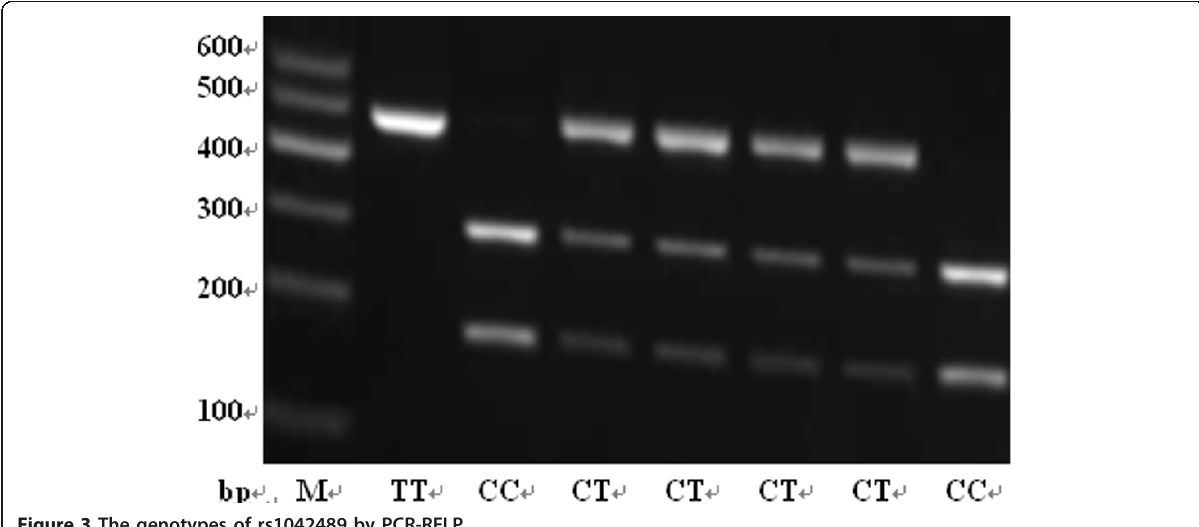
Figure 3 The genotypes of rs1042489 by PCR-RFLP